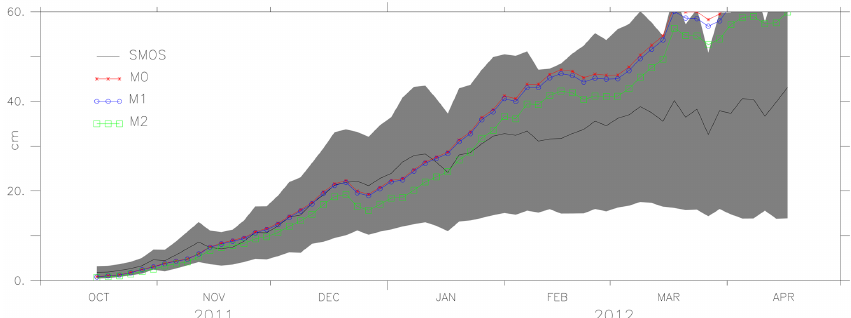
Figure 8. The ice thickness from models M0, M1 (ice concentration was not assimilated as there were no AMSR-E data available, but the initial conditions from the model assimilated with ice concentration were used), M2 (assimilated only with SST and used model initial conditions derived from assimilating both ice concentration and SST) and observations (SMOS ice thickness) from October 2011 to April 2012. The uncertainty in the observation (SMOS ice thickness) is shaded in grey.